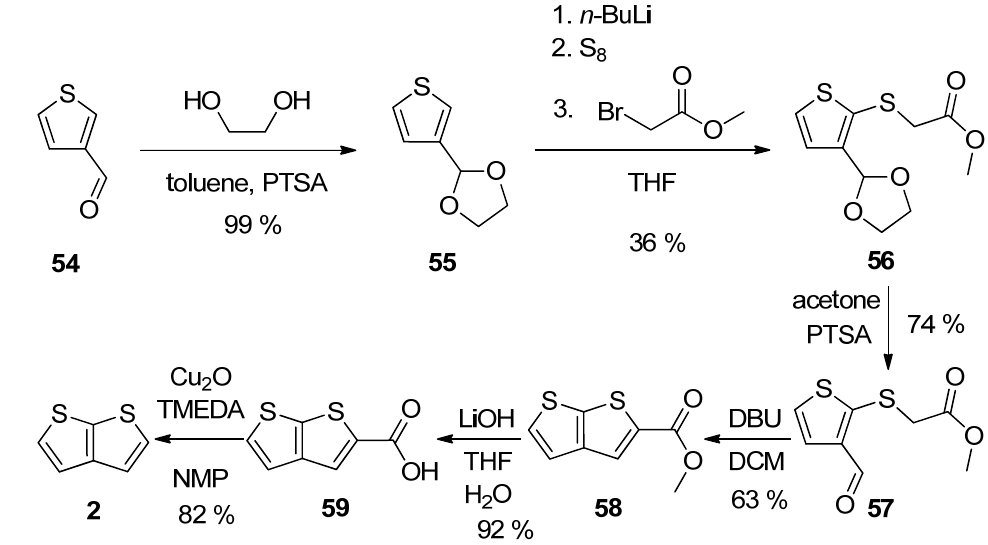
Table 1. The summary of the reviewed synthetic